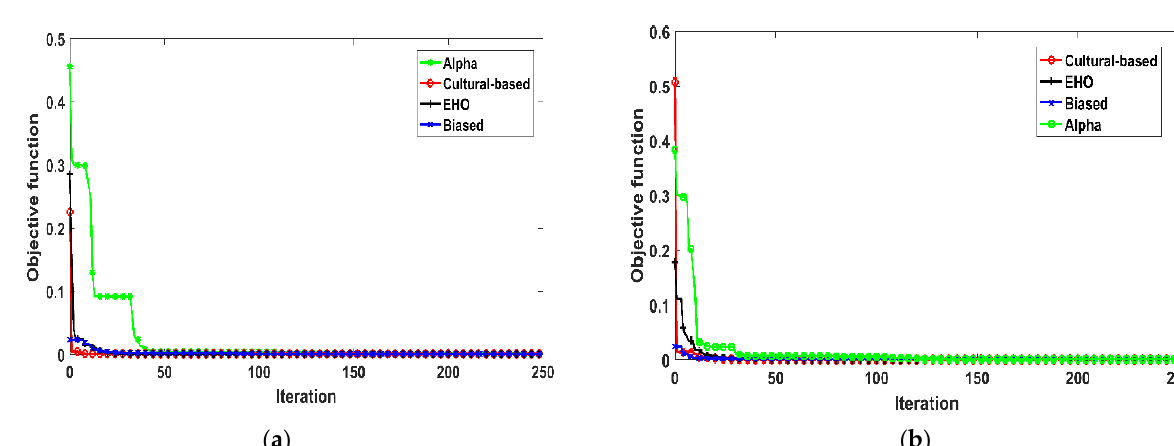
Figure 7. Convergence rates of EHO and its variants. ( a ) single diode. ( b ) double diode. As demonstrated by Table 5, the measured current is very close to the calculated current. In Table 3. Comparison between EHO algorithms, ABS, and HS for single-diode solar cells. addition, cultural-based EHO leads to outperformed results compared with other EHO variants. Figures 8 and 9 show the power and current of the calculated and measured current from cultural-based EHO. Again, the measured and calculated curves are almost identical, while the relative error for the double-diode model for cultural-based EHO is presented in Table 6. The previous results were for the PV panels at standard temperature and radiation. The four EHO algorithms were tested against three other algorithms at different irradiance levels and temperatures for more testing. Table 7 shows the extracted parameters for the seven algorithms at different irradiance levels and temperatures. Finally, the three-diode model is tested against three algorithms from [43] (Moth-Flame Optimizer (MFO), FPA, and Hybrid Evolutionary algorithm (DEIM)). The RMSEs for each algorithm at varying irradiance levels are listed in Table 8. Again, at low radiation with 109.2 W/m 2 , CEHO outperforms EHO with a slightly small difference but a big difference compared to other algorithms. CEHO outperformed other algorithms at other radiations, and BIEHO’s results were slightly different from CEHO’s. The superiority of the CEHO algorithm is proven as the best compared with the other three variants and the other three algorithms for all irradiance levels. Figure 10 shows that calculated data fit the I-V curve of measured data for